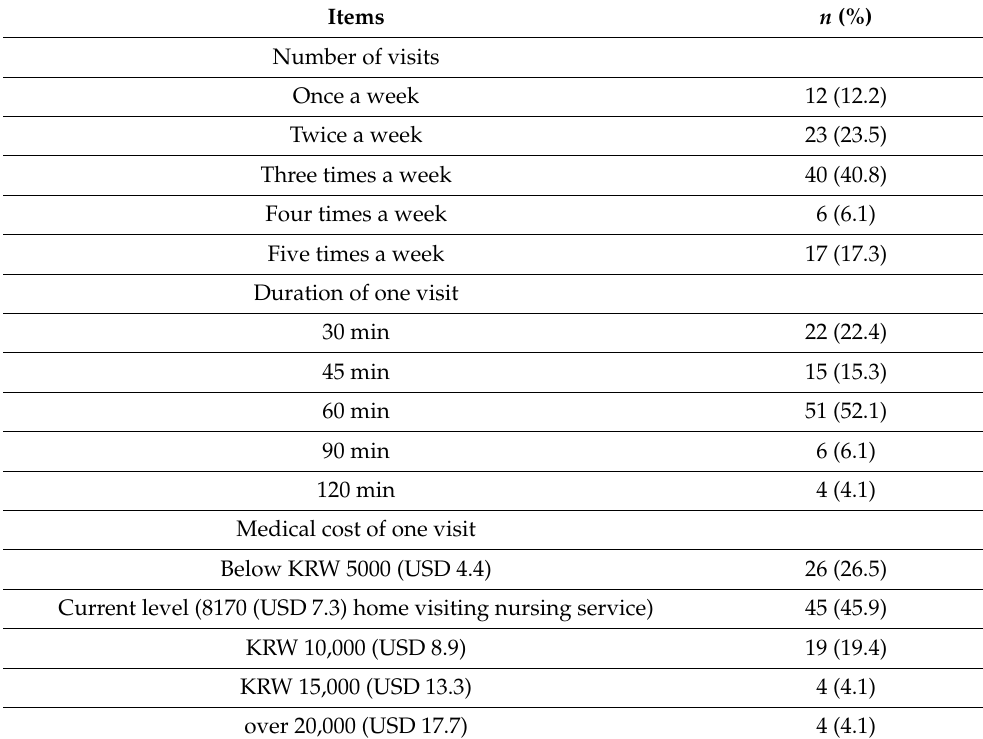
Table 3. Preferred number of home-based rehabilitation treatment visits, duration and cost ( n = 98). Items n